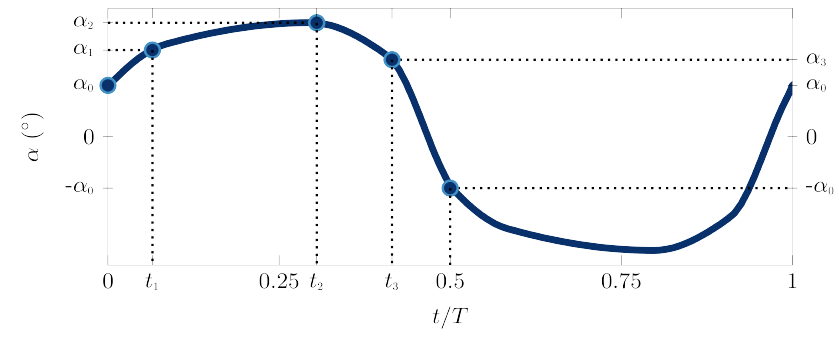
) , ( t ) , ( t ) , and ( t , α , α 0 1 1 2 2